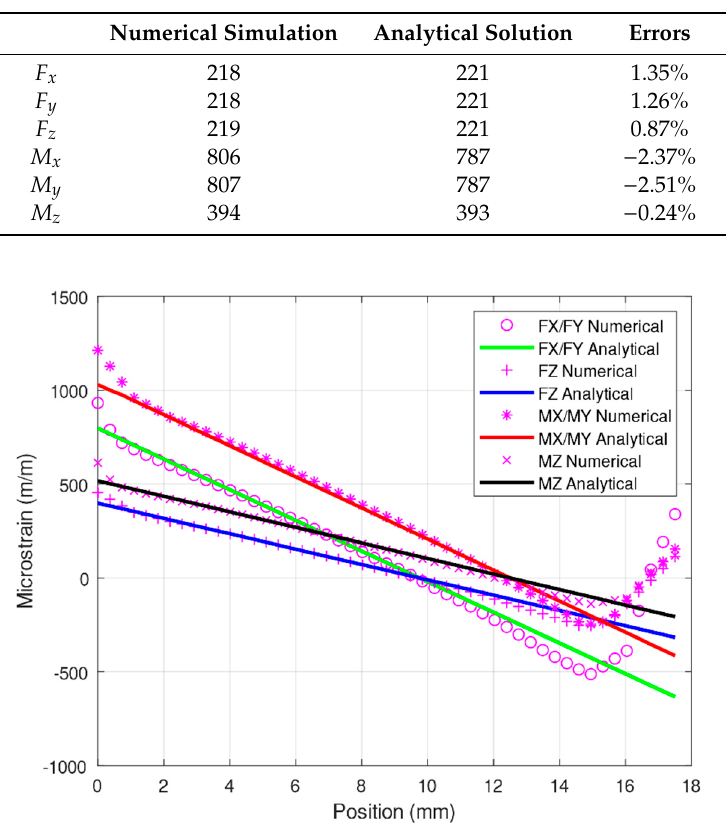
Table 2. Comparison of strains on elastic beam between numerical simulation and analytical solution.